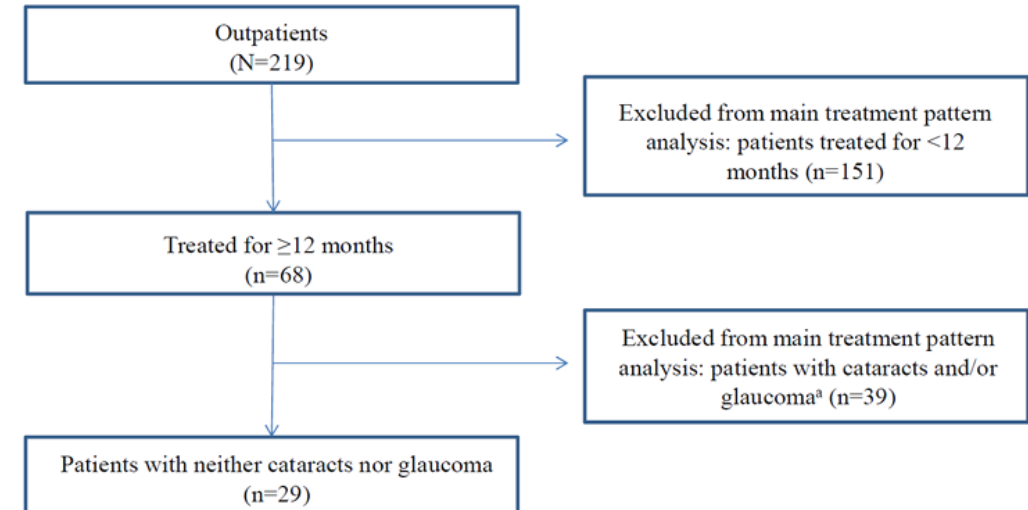
Figure 2. Patient